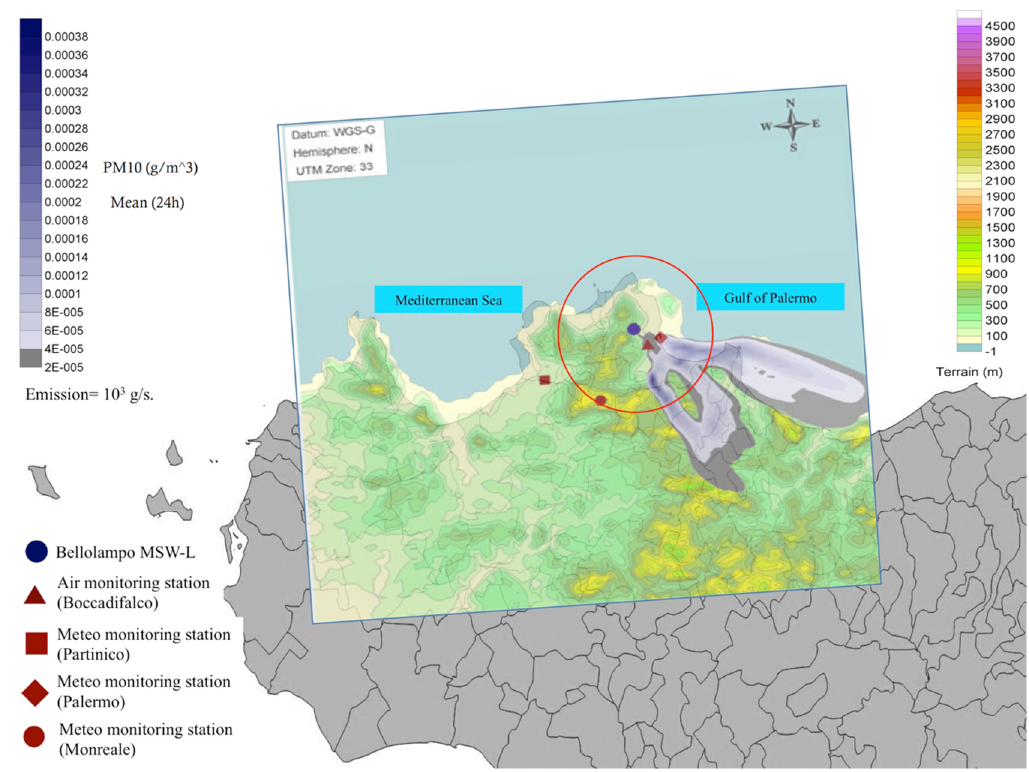
Figure 1. Reconstruction of the Bellolampo landfill environmental scenario. The red circle identifies the “protection area”.